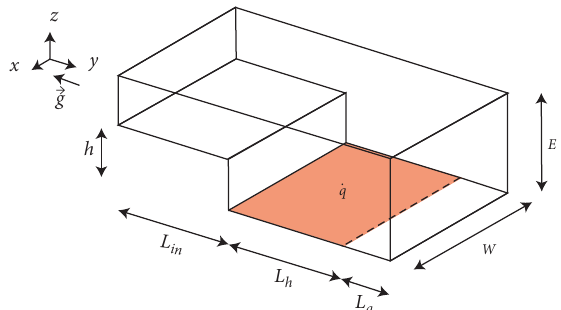
Figure 11: Backward-facing step geometry from Da Vi`a